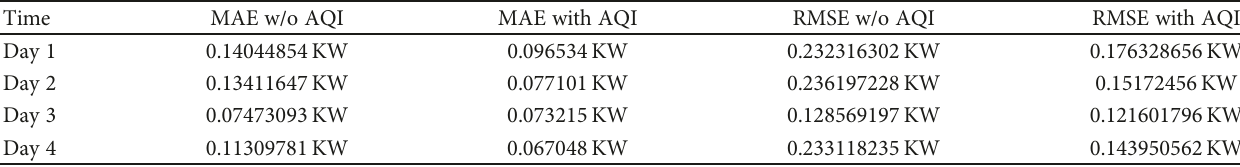
Table 2: Errors in KW during haze